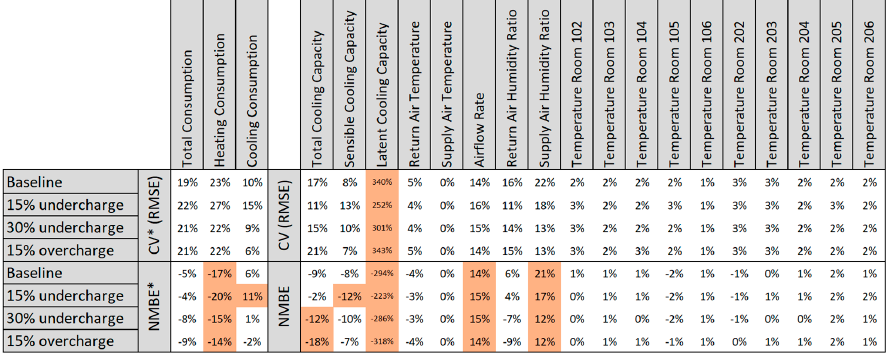
Table 7. CV (RMSE) and NMBE calculations for detailed model outputs: Nonstandard refrigerant charging.